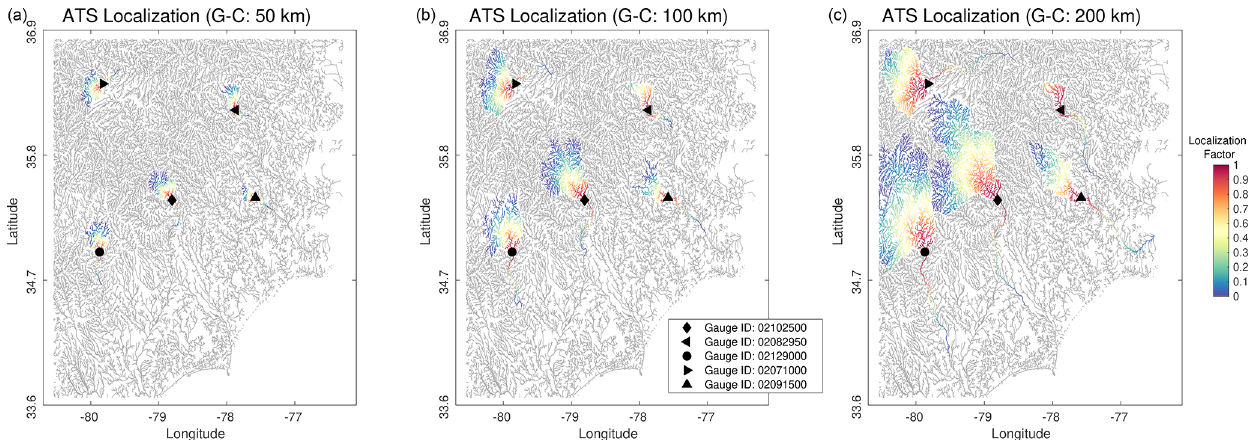
Figure 4. Illustration of the along-the-stream (ATS) localization strategy in the model domain using the following three different effective localization radii: 50km (a) , 100km (b) , and 200km (c) . The resulting localization factor α is displayed for five different stream gauges. The correlation function used to compute α is based on the Gaspari–Cohn (G–C) fifth-order compactly supported Gaussian-like